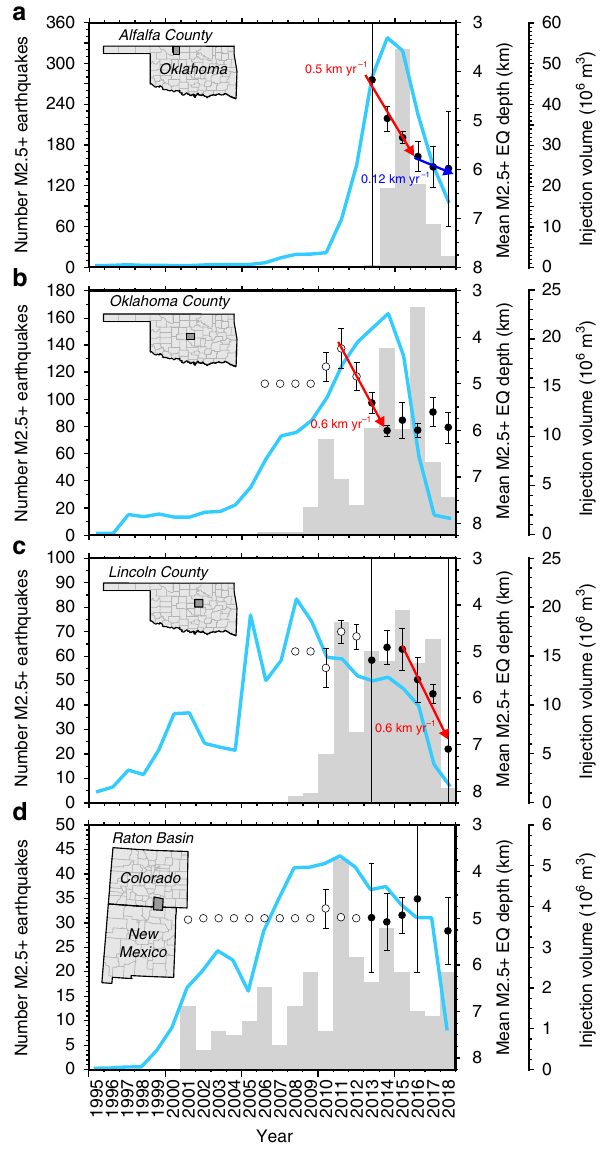
Fig. 1 Summary earthquake and wastewater data within study areas. Annual M2.5 + earthquake count (gray bars), salt water disposal volume (light blue line), and mean earthquake depth (circles) for a Alfalfa, b Oklahoma, and c Lincoln Counties, which are located in Oklahoma, USA. Panel ( d ) presents the same data for the Raton Basin of Northern New Mexico and Southern Colorado. Mean annual earthquake depth from 2013 to 2018 (solid circles) are weighted by inverse square depth error. Before 2013, mean annual earthquake depths (open circles) are calculated as an arithmetic mean because depth errors were infrequently reported. Error bars correspond with two standard errors. Note that open circles lacking error bars arise because shallow earthquakes were commonly reported